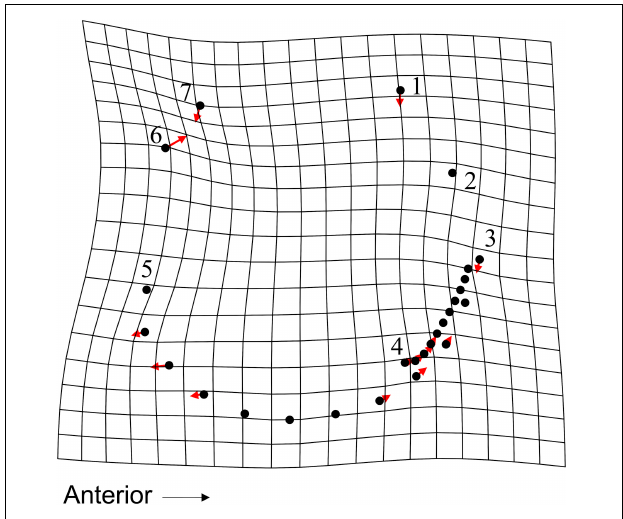
FIGURE 11 | TPS grid, with vectors showing magnitude and direction of LM and SLM deformation, illustrating deformation along CV1 for the 3-group CVA. Deformation shows difference from a live specimen (CV1 = –3.73, CV2 = 0.16) to a dead specimen from transects 8, 9, and 10 (CV1 = 3.4, CV2 =